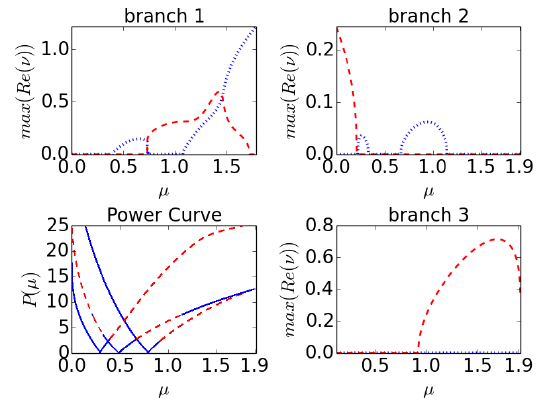
Figure 3. The bottom left plot shows the power of the solution ψ plotted in terms of the continuation parameter µ . The curves begin at the lowest power (i.e., at the linear limit) at the discrete real eigenvalues of approximately 0.286 (branch 1), 0.487 (branch 2), 0.785 (branch 3). Each power curve is drawn with its corresponding stability noted: a blue solid curve denotes a stable solution and a red dashed curve denotes an unstable solution. The other three plots track the maximum real part of eigenvalues ν as a function of the continuation parameter µ : the red dashed line represents the max real part of eigenvalues that are real (exponential instability) while the blue dotted line tracks the max real part for eigenvalues that have a nonzero imaginary part (quartets); this case corresponds to oscillatory